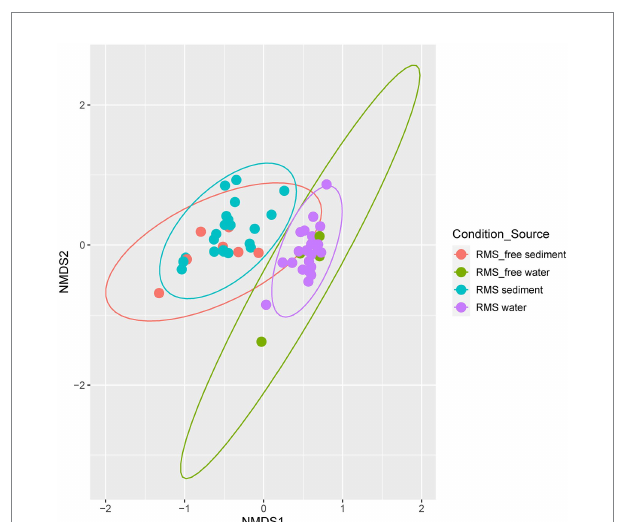
FIGURE 4 NMDS based on Bray–Curtis dissimilarity metric. Samples are colored by “Condition_Source”, representing the combination of sample source (sediment or water) and tank condition (RMS-free or